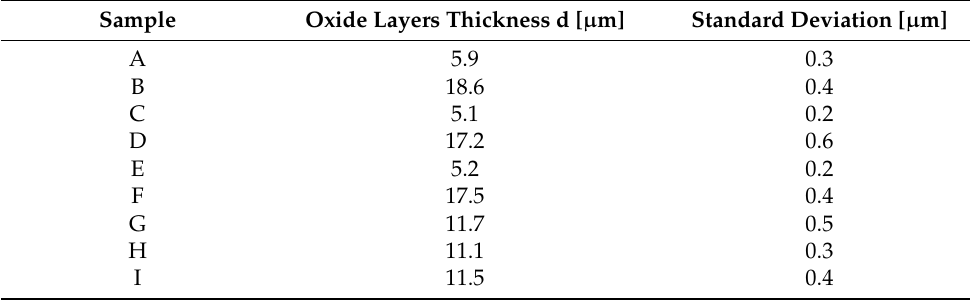
Table 4. List of Al 2 O 3 layers thicknesses produced in anodizing